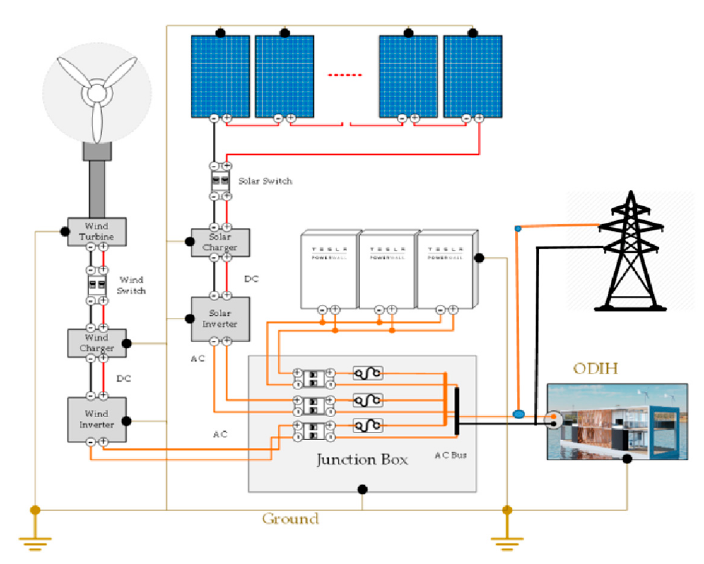
Figure 1. The energy system of the ODIH, reprinted with permission from [31]. Copyright 2021